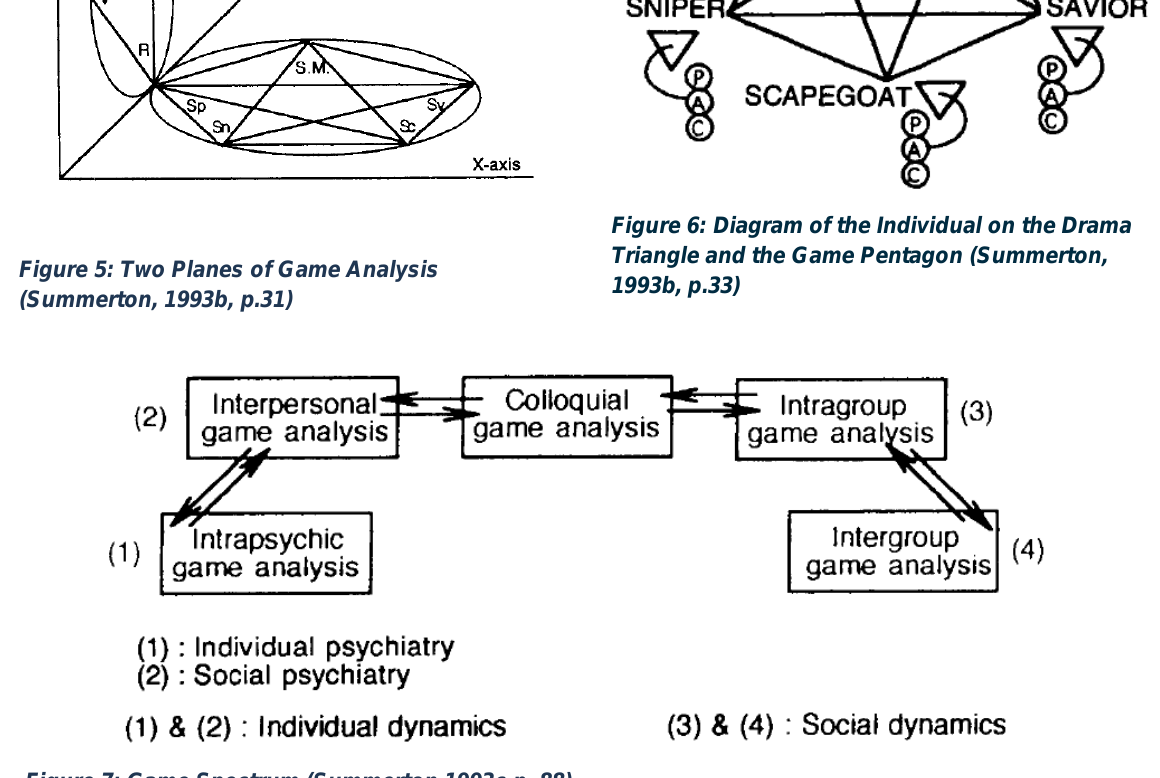
Figure 7: Game Spectrum (Summerton 1993c p.